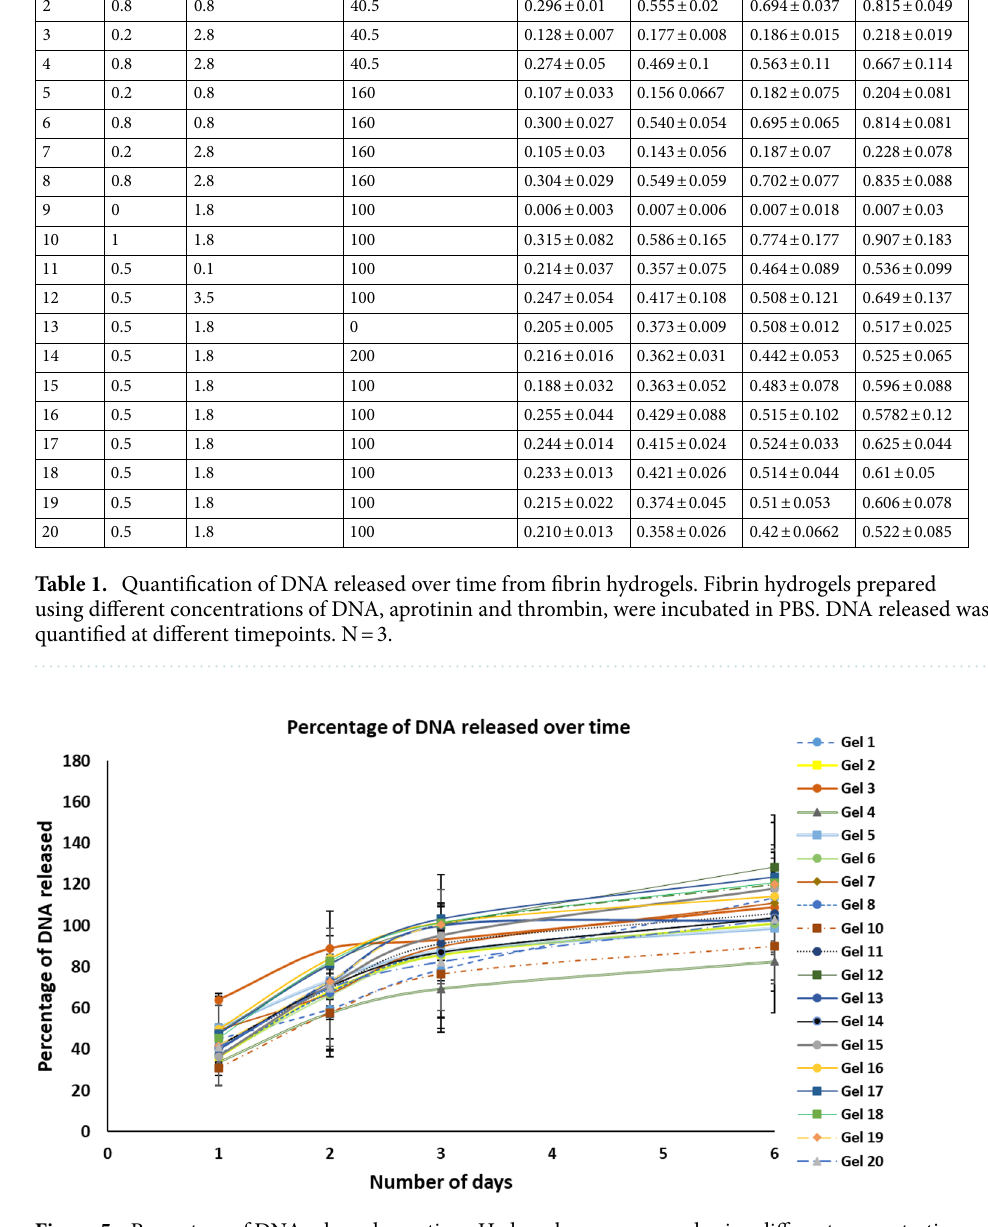
Fibrin hydrogels allowed diseased cells to synthesize and secrete the recombinant CTNS. Pri- mary fibroblasts from a patient with cystinosis were finally seeded on hydrogels prepared using parameters optimised in “Optimisation of transfection system and DNA conjugation strategy” and “DOE allowed the iden- tification of variables affecting transfection efficiency, cellular viability, and biomaterial degradation rate” sec- tions. Hydrogels loaded with the empty vector pCMV6-AC-GFP were used as control (group tGFP in Fig. 9). As shown in Fig. 9A, two days after cell seeding, many tGFP-expressing cells were observed. Particularly, for the empty plasmids, the fluorescent signal appeared uniform within the cytoplasm, whereas for the CTNS-encoding plasmids, a dot-like pattern was observed, indicating that the tagged protein localised to lysosomes. As shown in